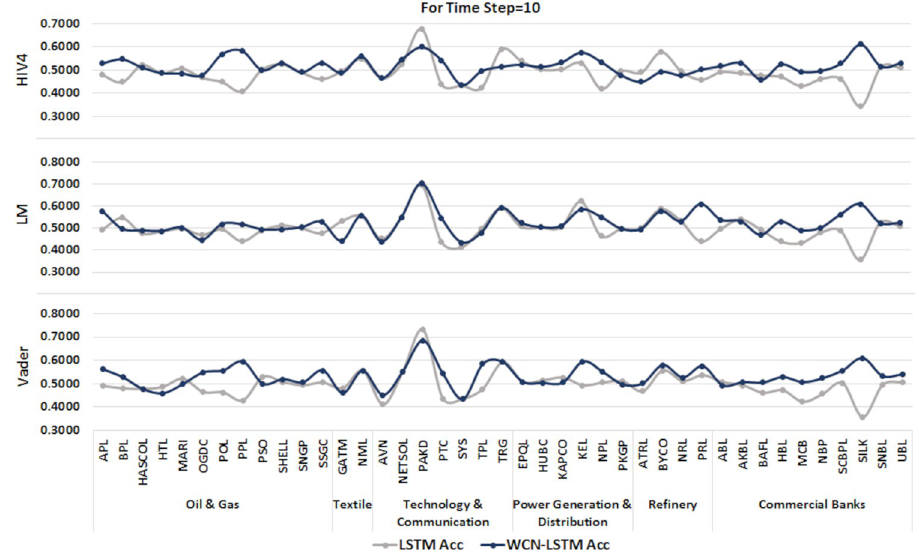
Fig 8. Accuracy of prediction models by incorporating information from the last 10 days using the test set.